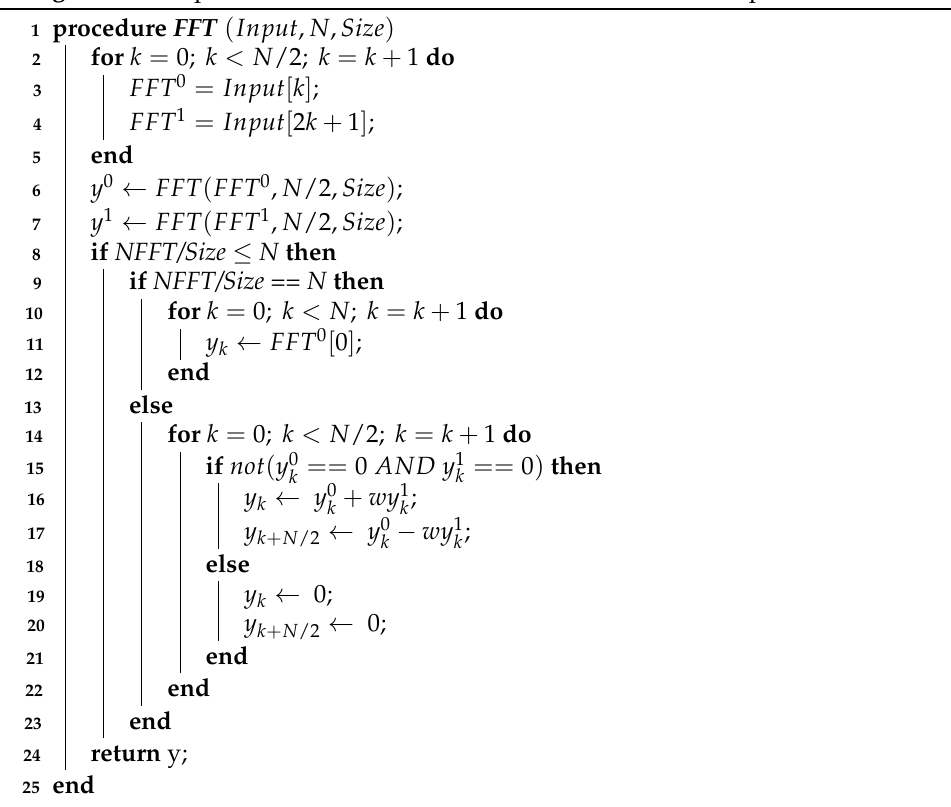
Algorithm 1: Optimized recursive fast Fourier transform for zero-padded